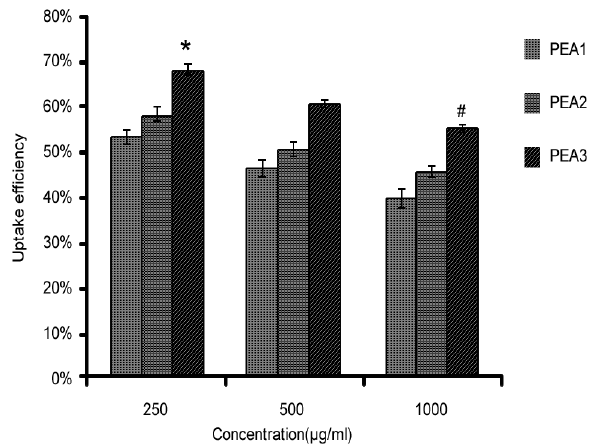
Figure 3. Cellular uptake of different PEA-NPs by Caco-2 cells at various concentrations for 4 h. Note: * represents significance among various DS groups at the same concentration, and # represents significance among various concentration at the same DS.